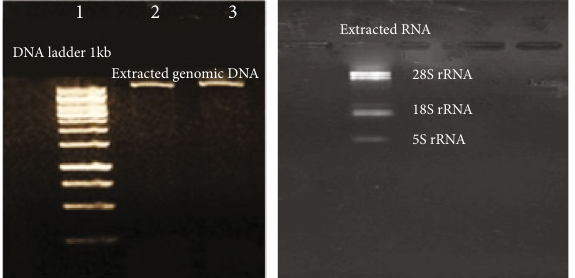
Figure 1: (a) Electrophoresis of extracted L. tropica genomic DNA. Lane 1: DNA ladder 1kb. Lanes 2 and 3: extracted L. tropica genomic DNA. (b) Electrophoresis of extracted L. tropica total RNA.